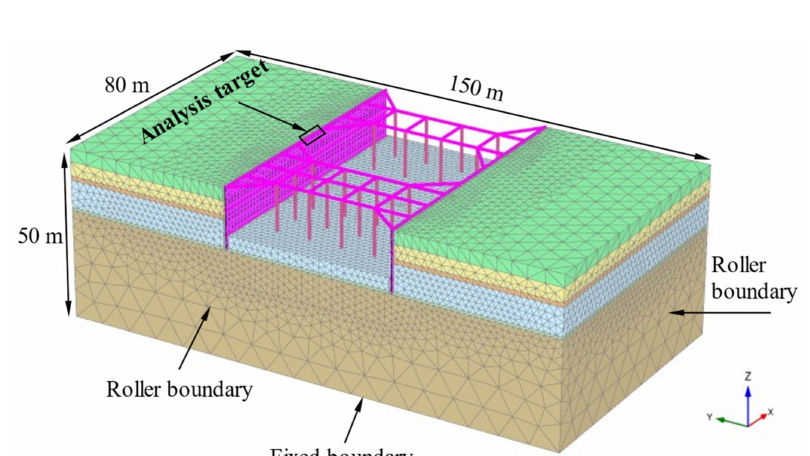
Figure 11. Example of mesh employed in the FE